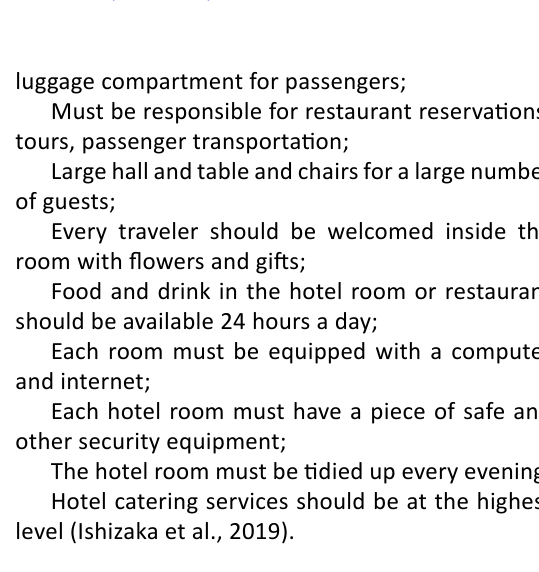
Fig 2: Hugman crisis management model (Clark,